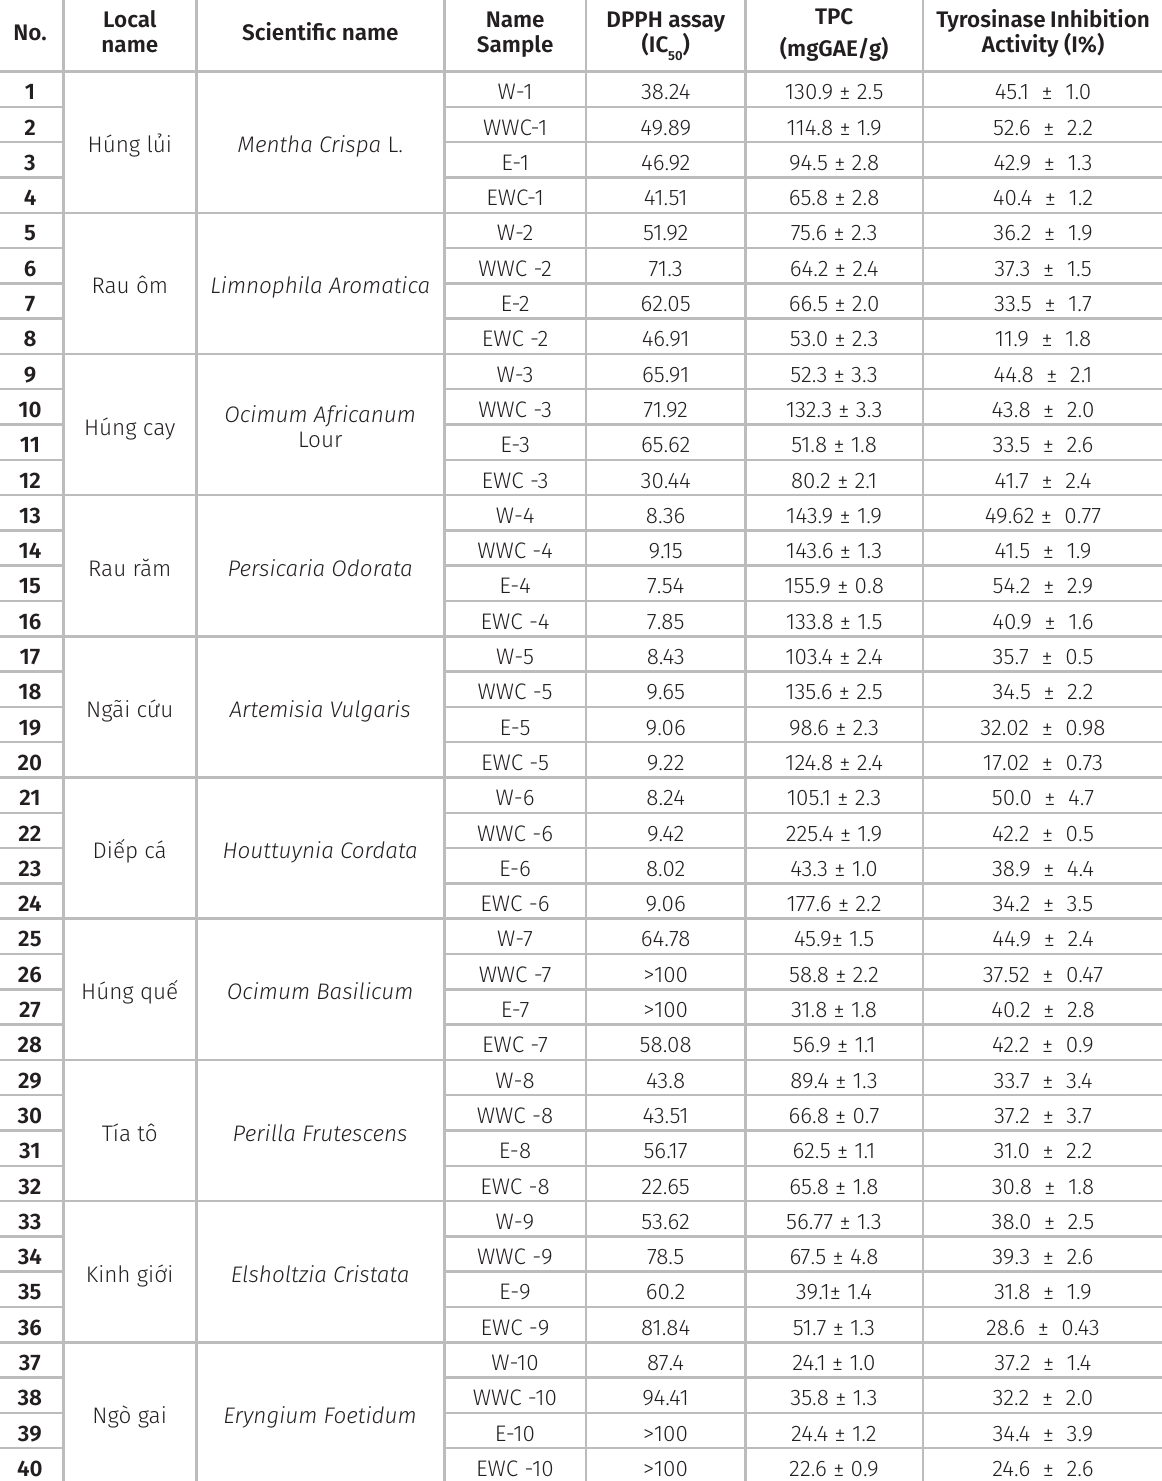
Table I. List of 40 extracts prepared from 10 spicy vegetables and their biological activities.